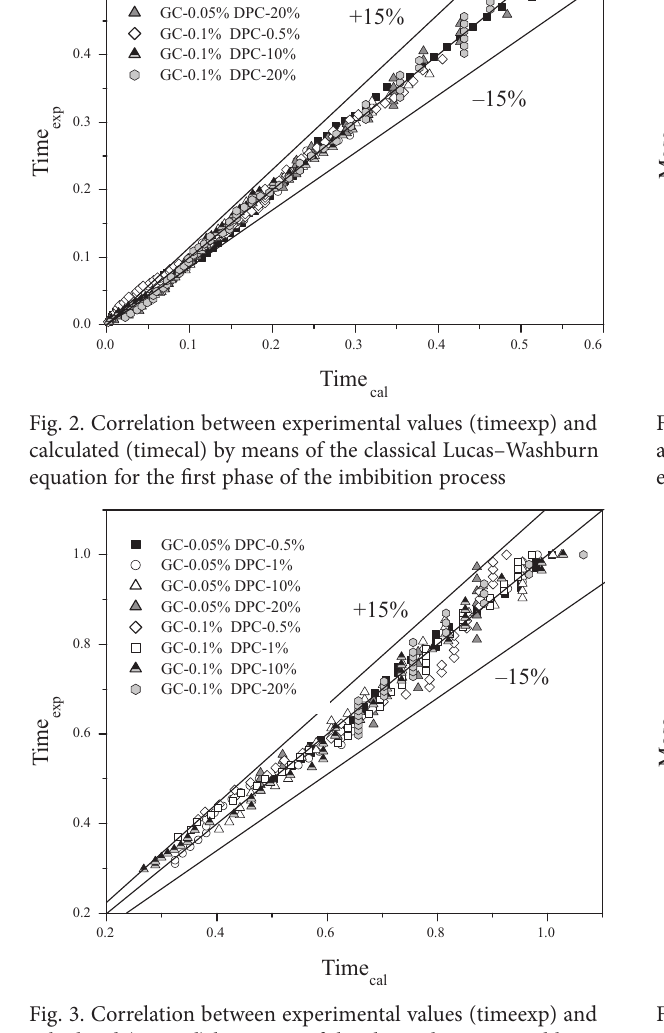
Fig. 3. Correlation between experimental values (timeexp) and calculated (timecal) by means of the classical Lucas–Washburn